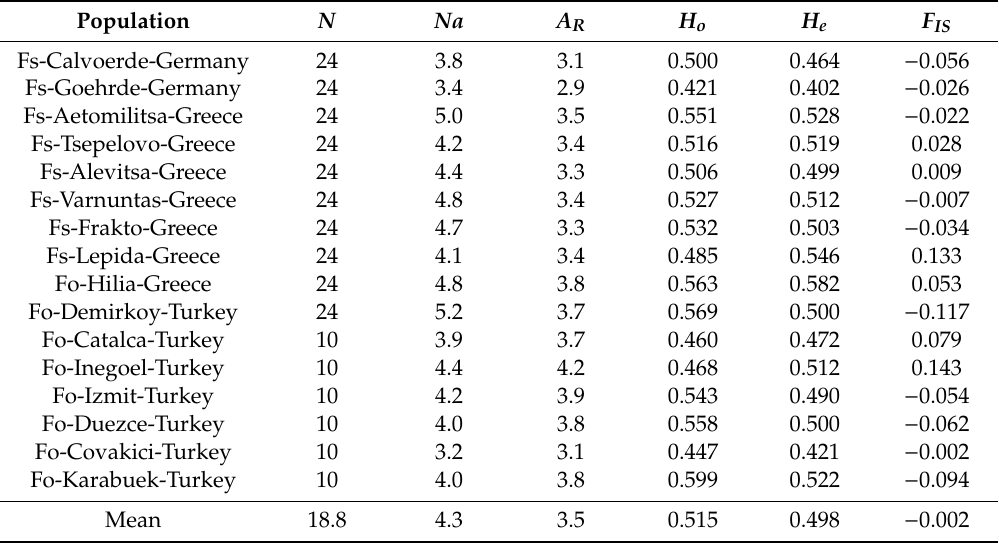
Table 3. Sample size and mean genetic diversity indices for all populations.